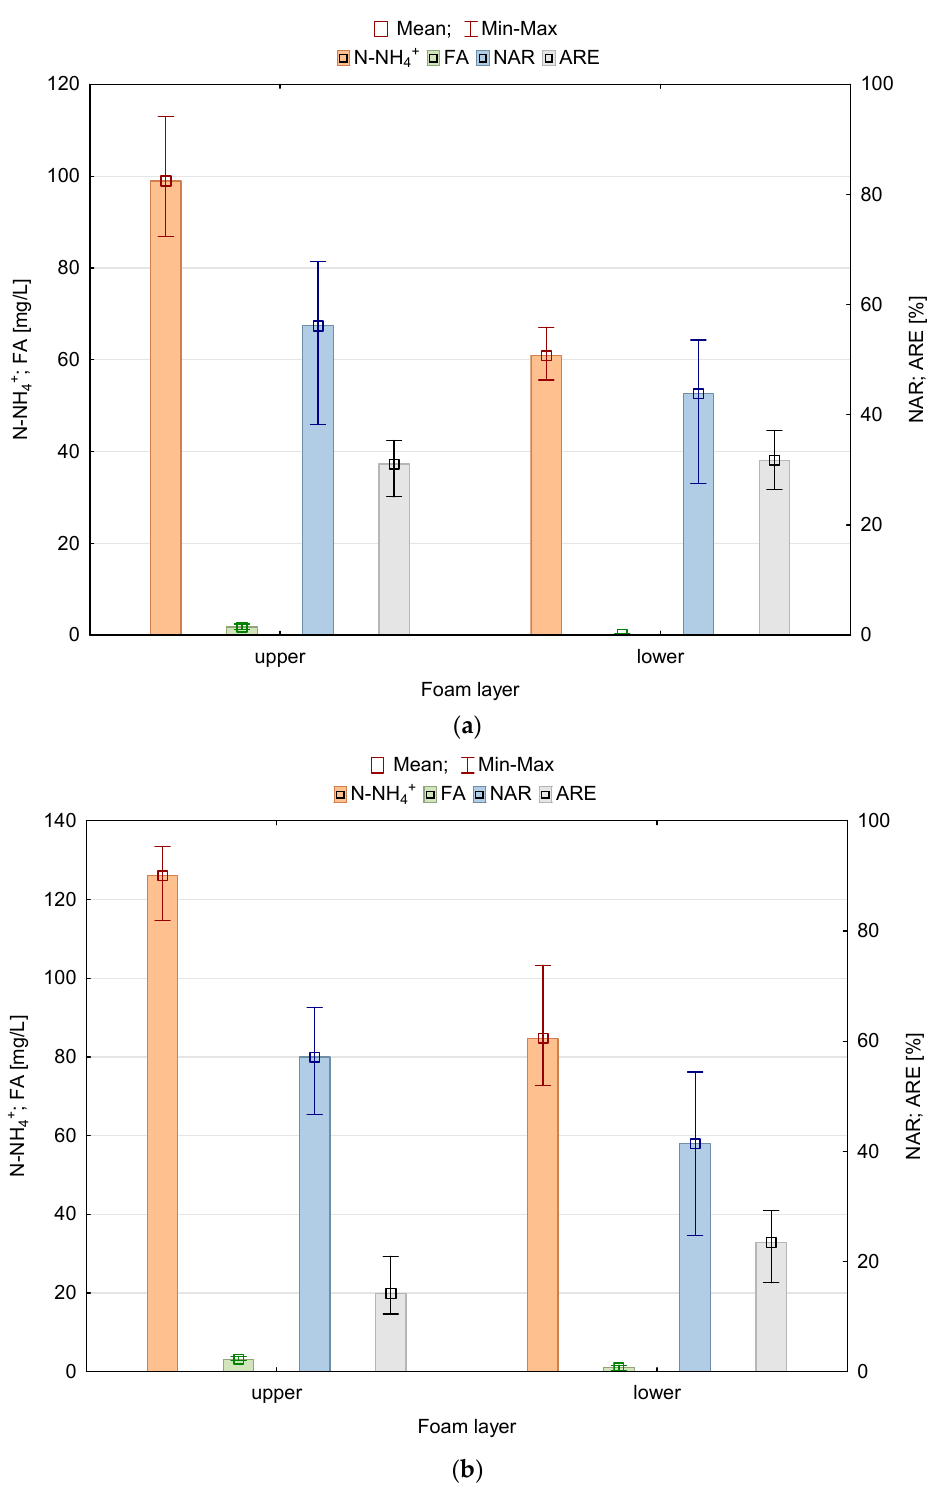
Figure 10. Box-plot chart for N-NH 4+ concentration, FA, NAR, and reduction of ammonium nitrogen ARE in subsequent foam layers of ( a ) column A and ( b ) column B.